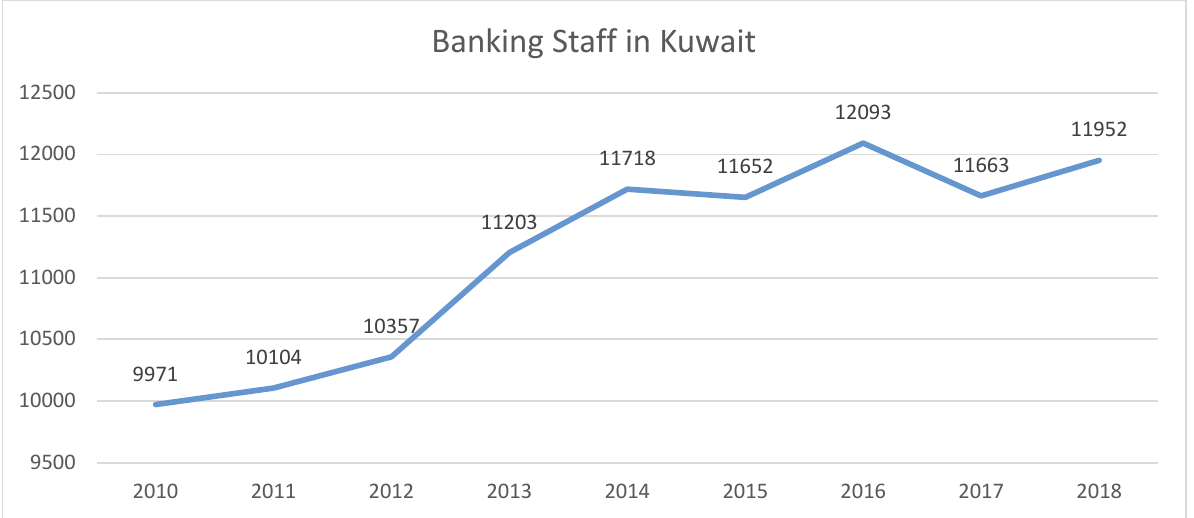
Fig.1. Number of Staff in Kuwaiti